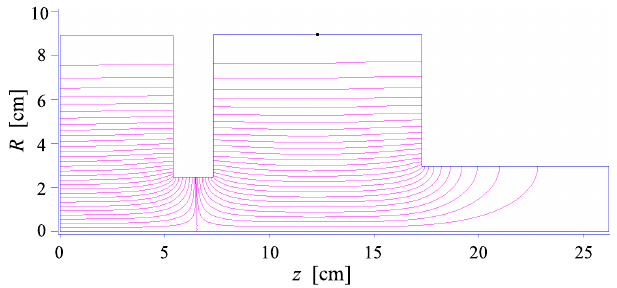
FIG. 20. Optimized straight line model of the cylindrically symmetric Photo Injector Test Facility Zeuthen (PITZ) rf gun geometry. Total length is 26.191 85 cm, and the horizontal axis is the symmetry axis. The isolines (magenta) computed by POISSON SUPERFISH show the magnetic ( RH (cid:8) component) field pattern for an accelerating mode.